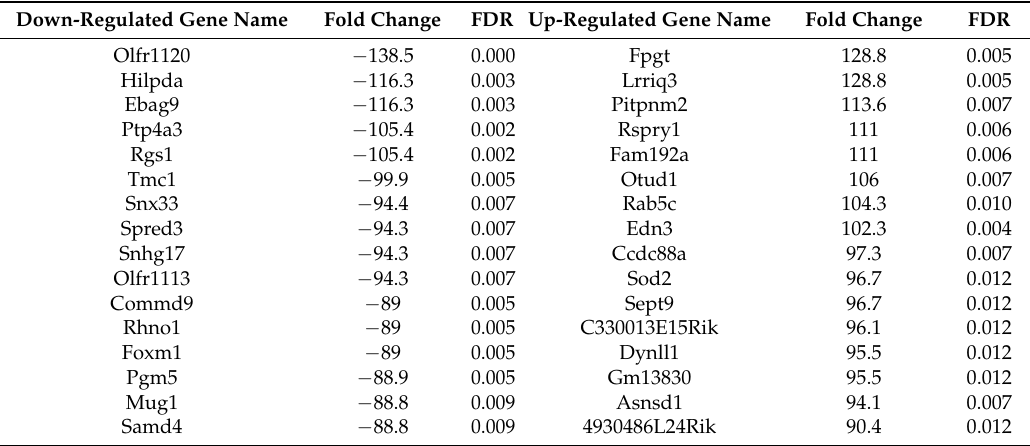
Table 5. Significantly changed genes corresponding to the differentially enriched peak.